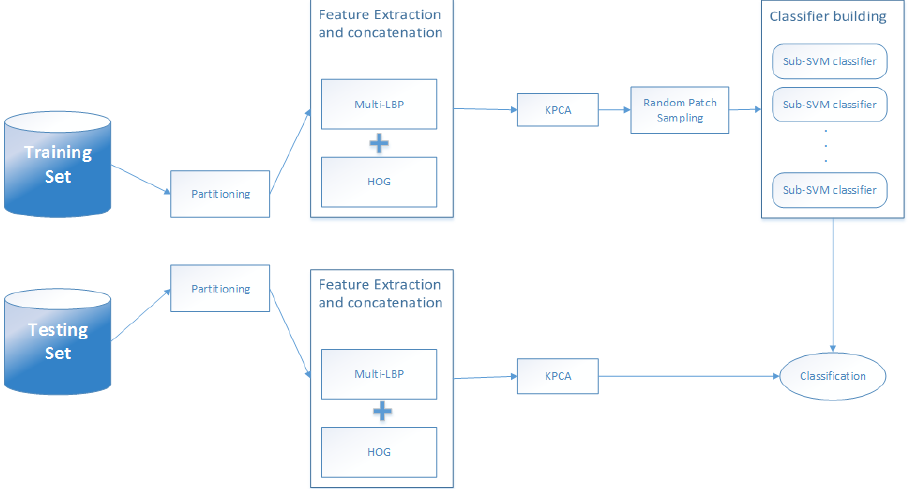
Figure 1. Diagram explaining Random Patch SVM for face